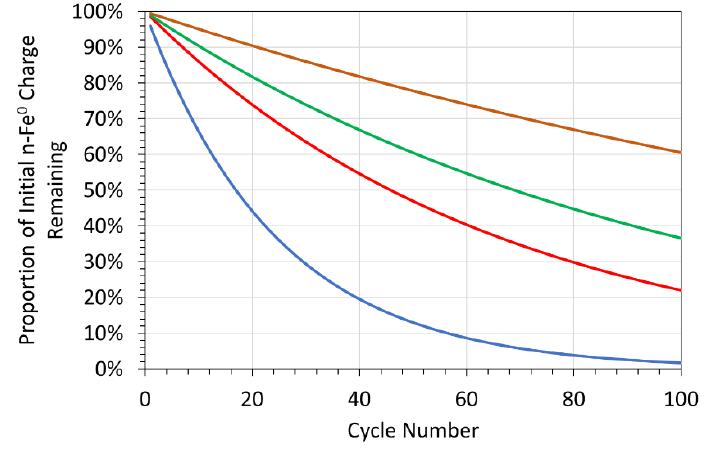
Figure A2. Relationship between the proportion of an initial n-Fe 0 charge remaining and reuse cycle number. Blue line = 96% reusable in the next cycle; red line = 98.5% reusable in the next cycle; green line = 99% reusable in the next cycle; brown line = 99.5% reusable in the next cycle.